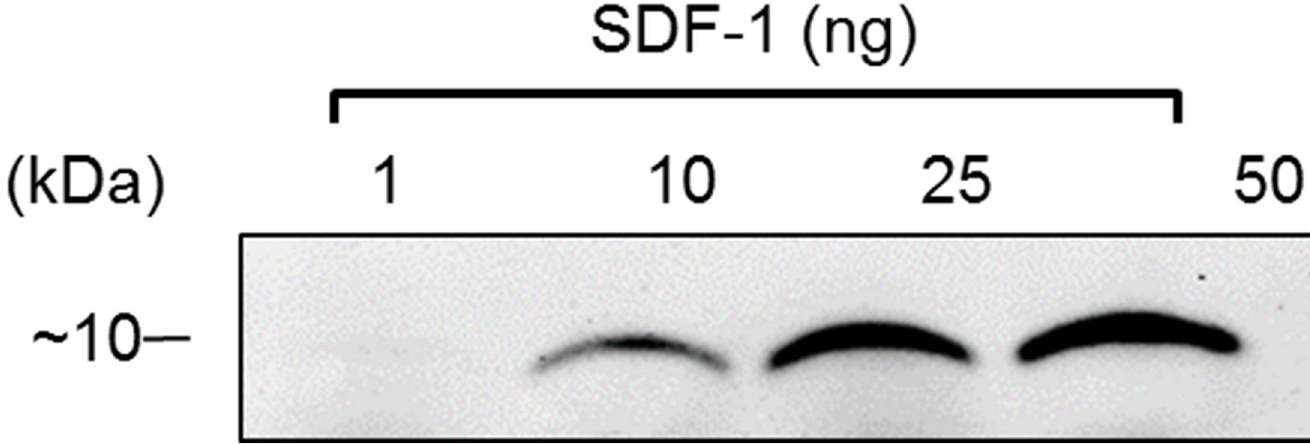
Fig 7. HCI.SDF1 used for Western blotting. Western blots demonstrated a concentration-signal relationship when HCI.SDF1 was used to detect varyingconcentrations of rhSDF-1 α .